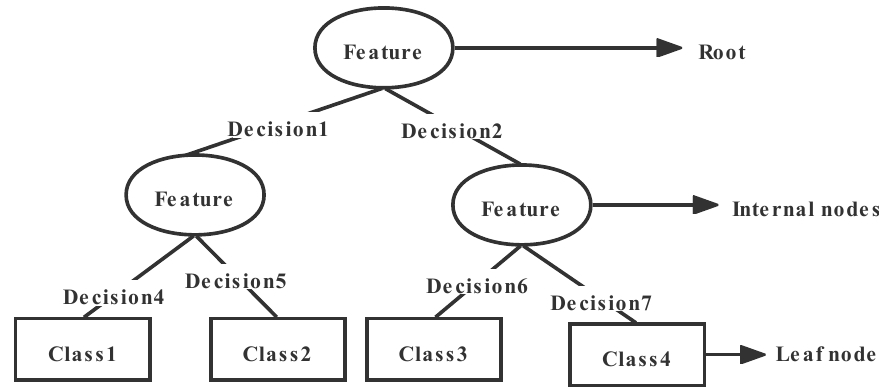
Figure 2. Tree-like structure of a decision